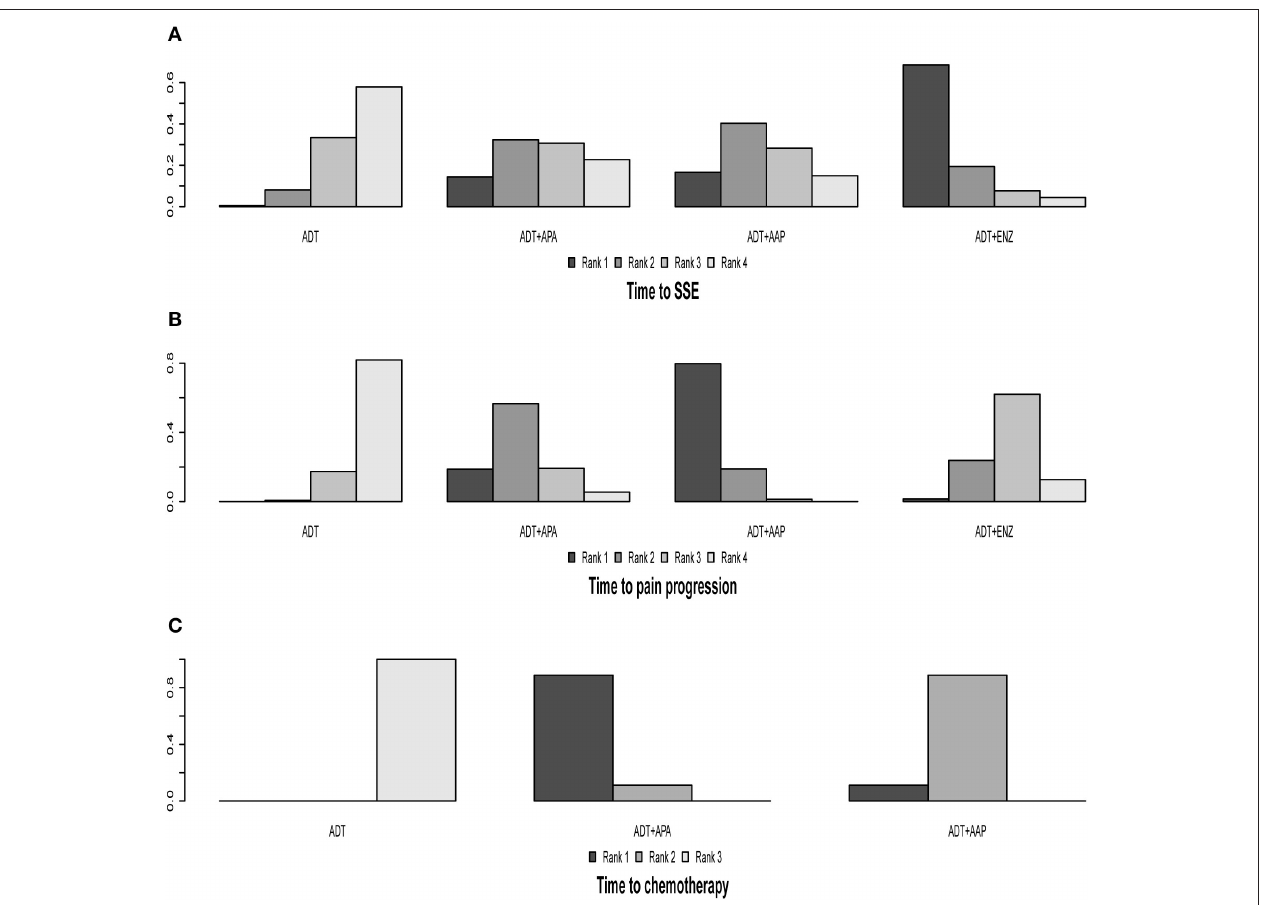
FIGURE 5 | Ranking plot based on the probabilities of interventions in the analysis of secondary outcomes. (A) Time to SSE. (B) Time to pain progression. (C) Time to chemotherapy. The height of each column reflects the probability of the